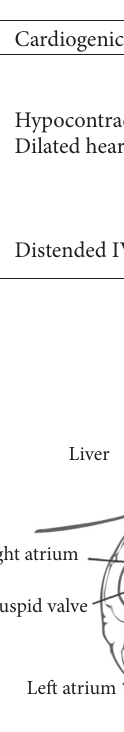
Table 1: Ultrasound findings in classic shock states.